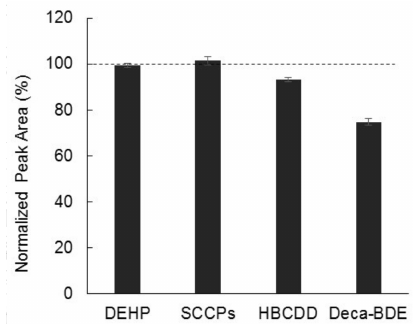
Figure 6. Results of the spike test with the addition of 1000 mg/kg mixed standard to the polystyrene solution. The value of each analyte is expressed relative to the concentration of the mixed standard. Error bars represent one standard deviation of three repeated